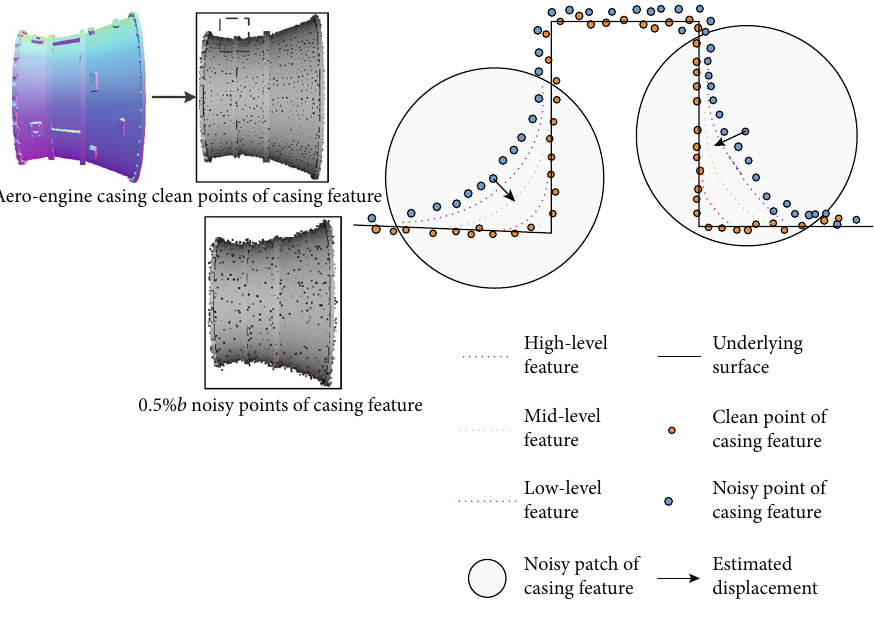
Figure 15: Illustration of casing feature denoising.